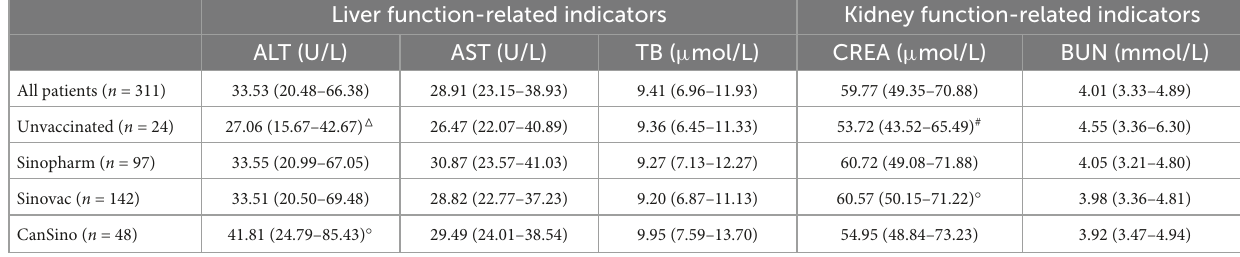
TABLE 4 The liver and kidney function-related indicators of convalescent adult patients in different groups. Liver function-related indicators Kidney function-related indicators